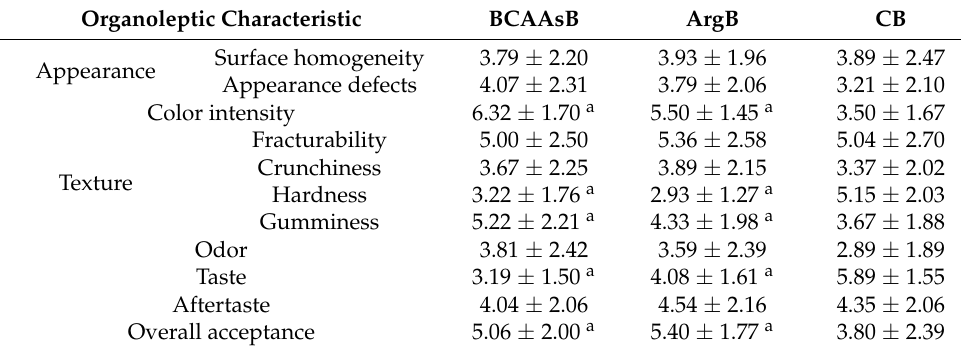
Table 5. Organoleptic characteristics of the three